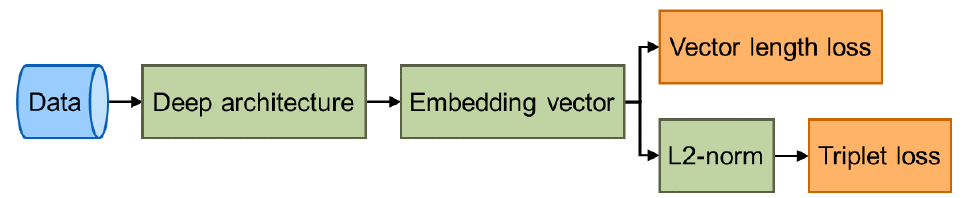
Figure 4. Stage 1 triplet loss and vector length loss learning model.